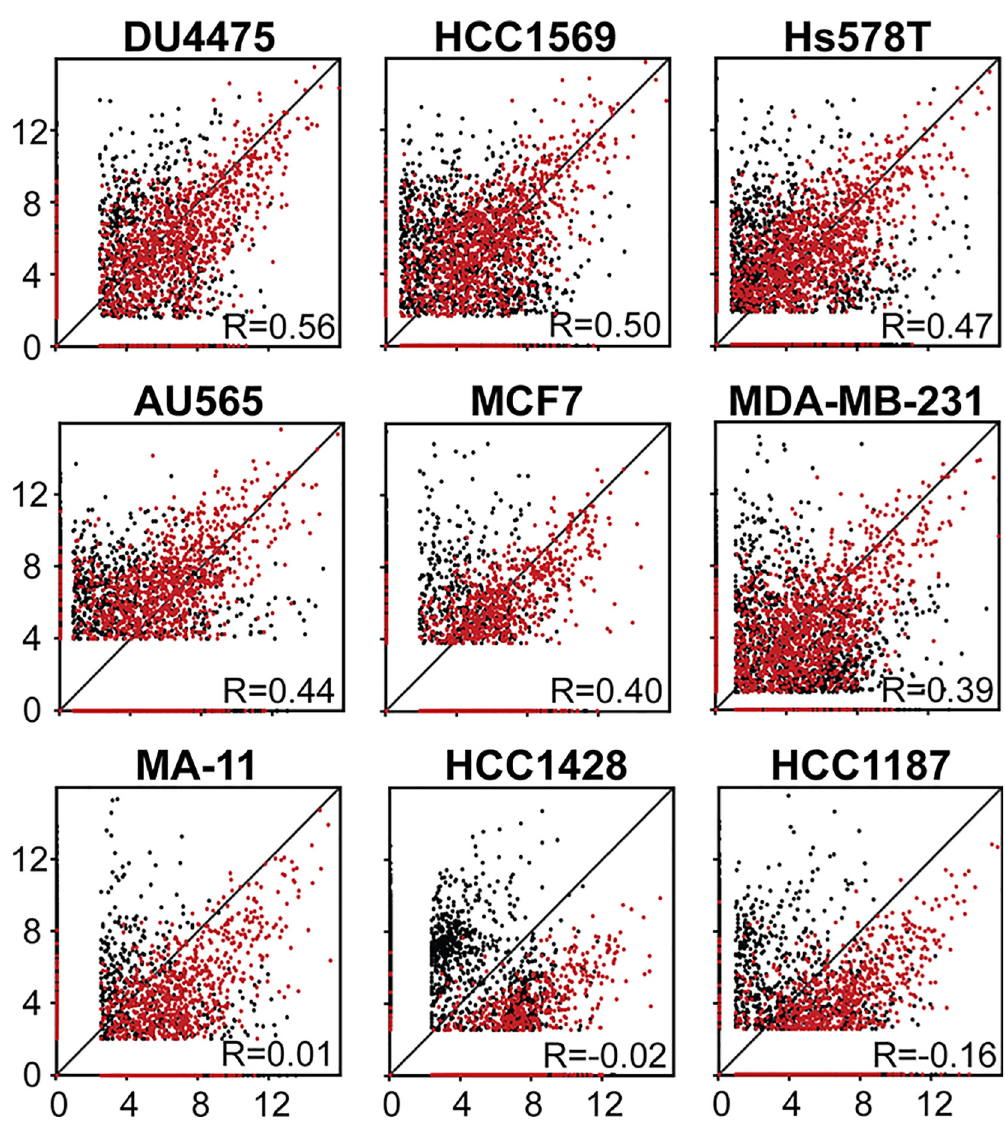
Fig 4. Scatterplot analysis showing the correlation between the small RNA expression pattern in nine breast cancer cell lines and the corresponding EVs isolated from cell culture media. Small RNA expression is given in log2 reads per million (RPM), with the cellular expression shown on the x-axis and the EVs on the y-axis. MiRNAs are plotted in red, while non-miRNA small RNAs are plotted in black. Pearson ’ s correlation is calculated for the total small RNA expression.